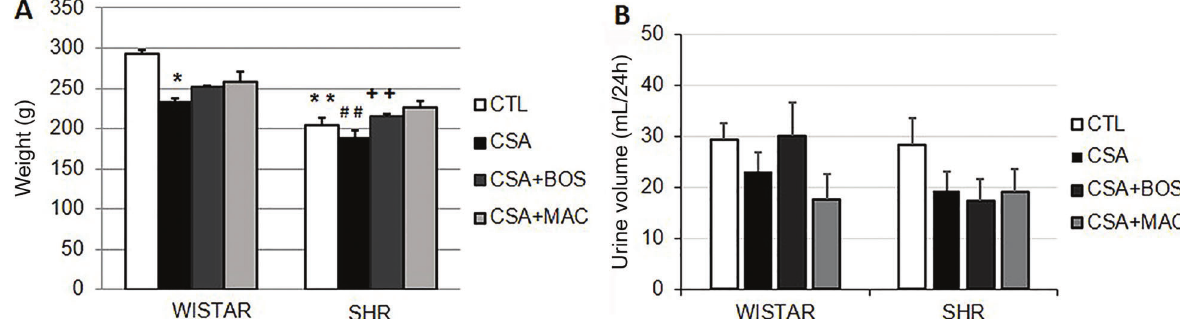
Figure 1. Quantitative analyses of A , body weight, and B , urine volume in Wistar rats (normotensive) and genetically hypertensive rats (SHR) in the control group (CTL), in rats receiving cyclosporine-A (CsA) or receiving CsA and treated with bosentan (CsA + BOS) or macitentan (CsA + MAC) for 15 days. Data are reported as means ± SE. The signi fi cance level for a null hypothesis was set at 5% (P o 0.05). *P o 0.05, compared to the CTL group; **P o 0.05 compared to the respective normotensive group; ## P o 0.05 compared to the respective CsA normotensive group. ++ P o 0.05 compared to the respective CsA + BOS normotensive group (ANOVA followed by the Tukey test or Student ’ s t -test).